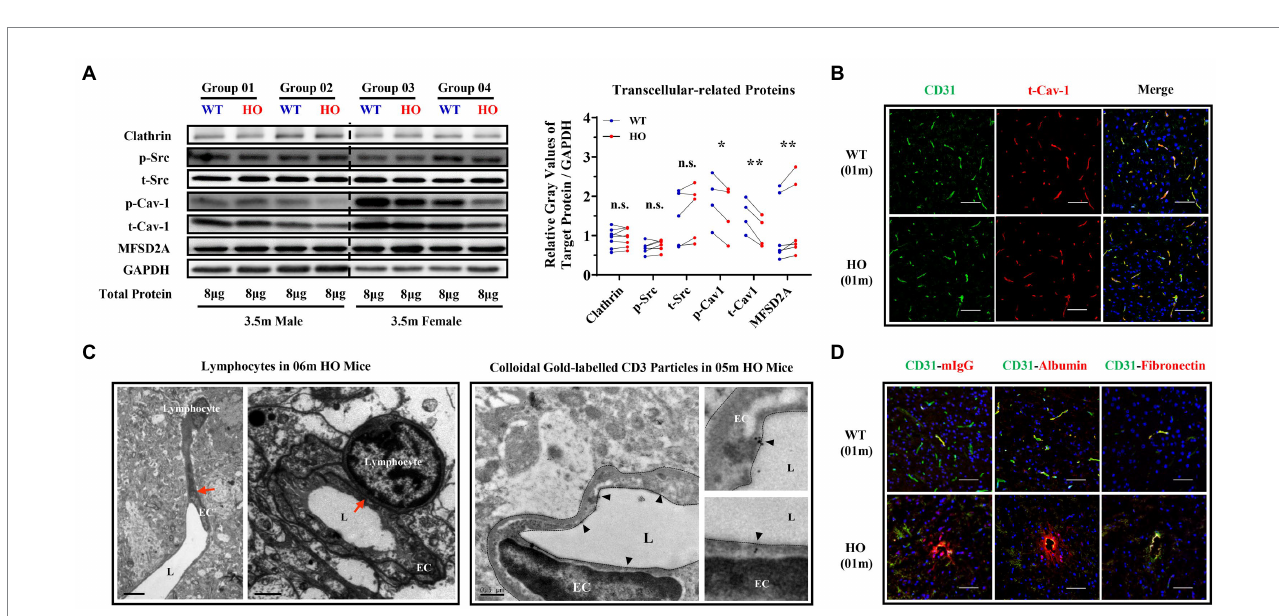
FIGURE 3 Transcellular Pathway Alterations in The brain endothelium of Slc20a2 -HO mice. (A) Expression of endocytosis- and transcytosis-related proteins in brain microvessels of 3.5-month-old Slc20a2 -WT and -HO mice. ** p < 0.01; * p < 0.05; n.s., not statistically significant. (B) Distribution pattern (localization, morphology, and polarization) of total caveolin-1 in 1-month-old mice. (C) The fusion of endothelial and lymphocyte cell membranes (red arrows) in 6-month-old -HO mice (C , Left ) . CD3 + colloidal gold particles in the endothelial cell membrane of the midbrain in 5-month-old -HO mice. Black triangles indicate gold particles (C , Right ) . EC, endothelial cell; L, vascular lumen. Scale bars, 6 and 1.5 μ m (C , left ) ; 0.5 μ m (C , right ) . (D) Endogenous IgG and albumin, rather than fibronectin, leaked into the brains of 1-month-old -HO mice. Scale bar, 40 μ m (B,D)